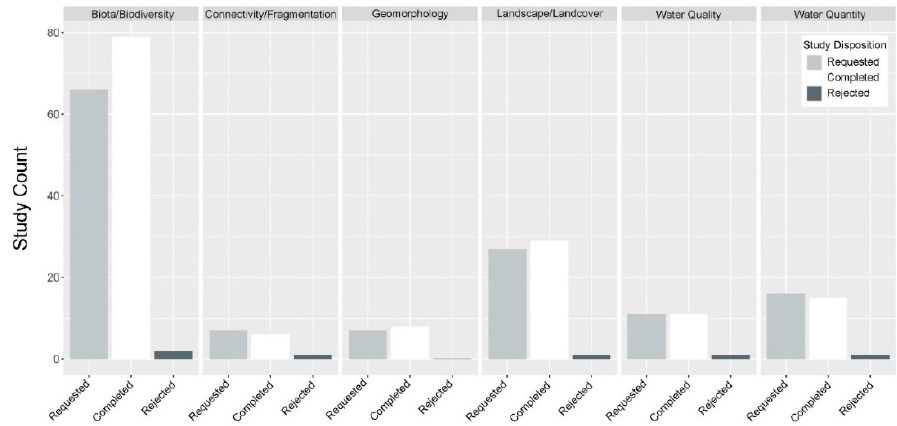
Figure 6. Number of studies that were completed, rejected, or requested, by study category, for the seven case study projects in dataset 2.